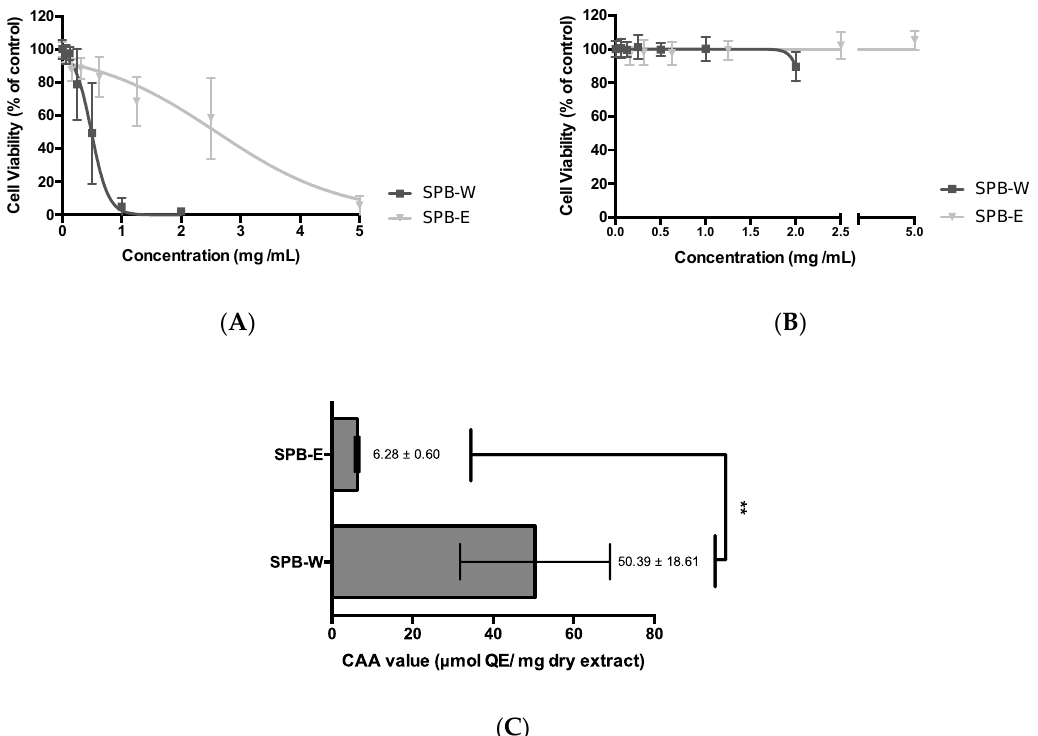
Figure 4. Dose-response curves of SBP extracts. Antiproliferative ( A ) and cytotoxicity ( B ) effects using HT29 and Caco-2 cell lines, respectively. Results are expressed in terms of mean ± SD performed in triplicate. Antioxidant activity of SBP extracts evaluated by CAA assay ( C ). Results are expressed as μmol quercetin equivalents (QE) per mg of dry extract of mean ± SD performed in triplicate. Unpaired t test was assessed with p -value < 0.01 (**).